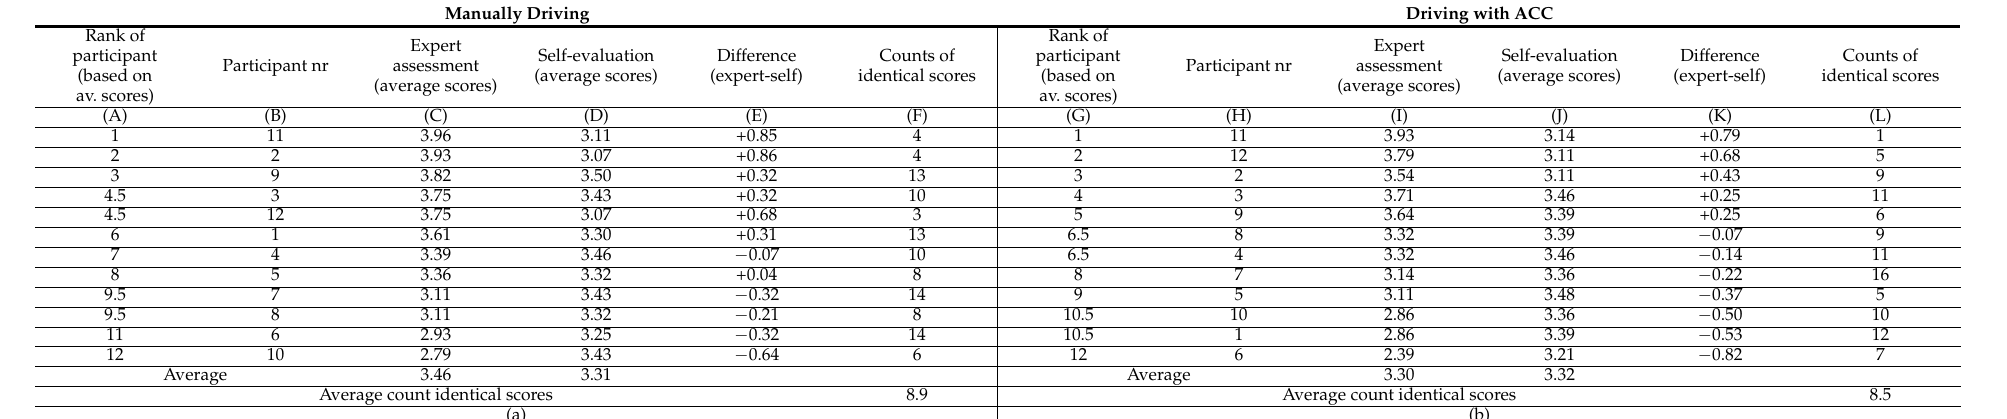
Table 2. Comparison between Expert-assessment and Self-evaluation. Scores refer to (a) manually driving and (b) driving with ACC. Scores are ranked from highest average scores of Expert-Assessment to